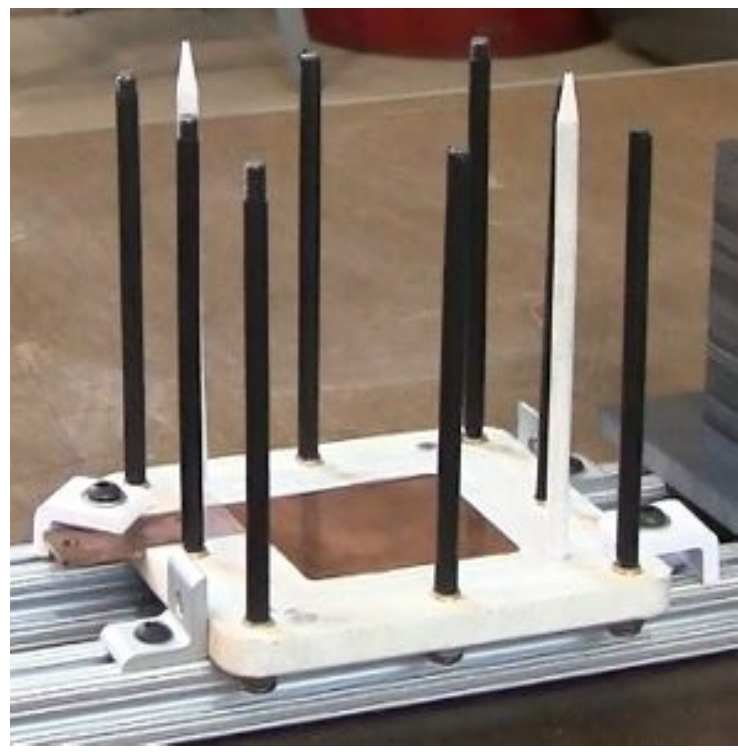
Figure 4. Endplate located and clamped in the assembly workcell. Two poly(tetra)fluoroethylene (PTFE) alignment pins (white) are permanently mounted on the endplate. The alignment pins feature a conical end which eases the engagement